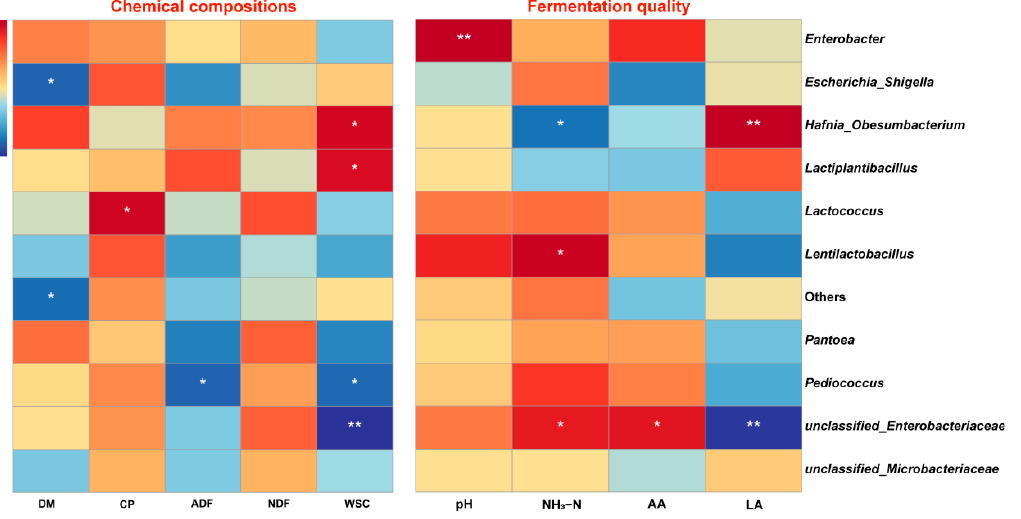
Figure 4. Heatmaps of Pearson’s correlations between dominant genera and chemical compositions and fermentation quality. Red represents a positive correlation, while blue represents a negative correlation. Levels of significance are shown as follows: * p < 0.05; ** p < 0.01.